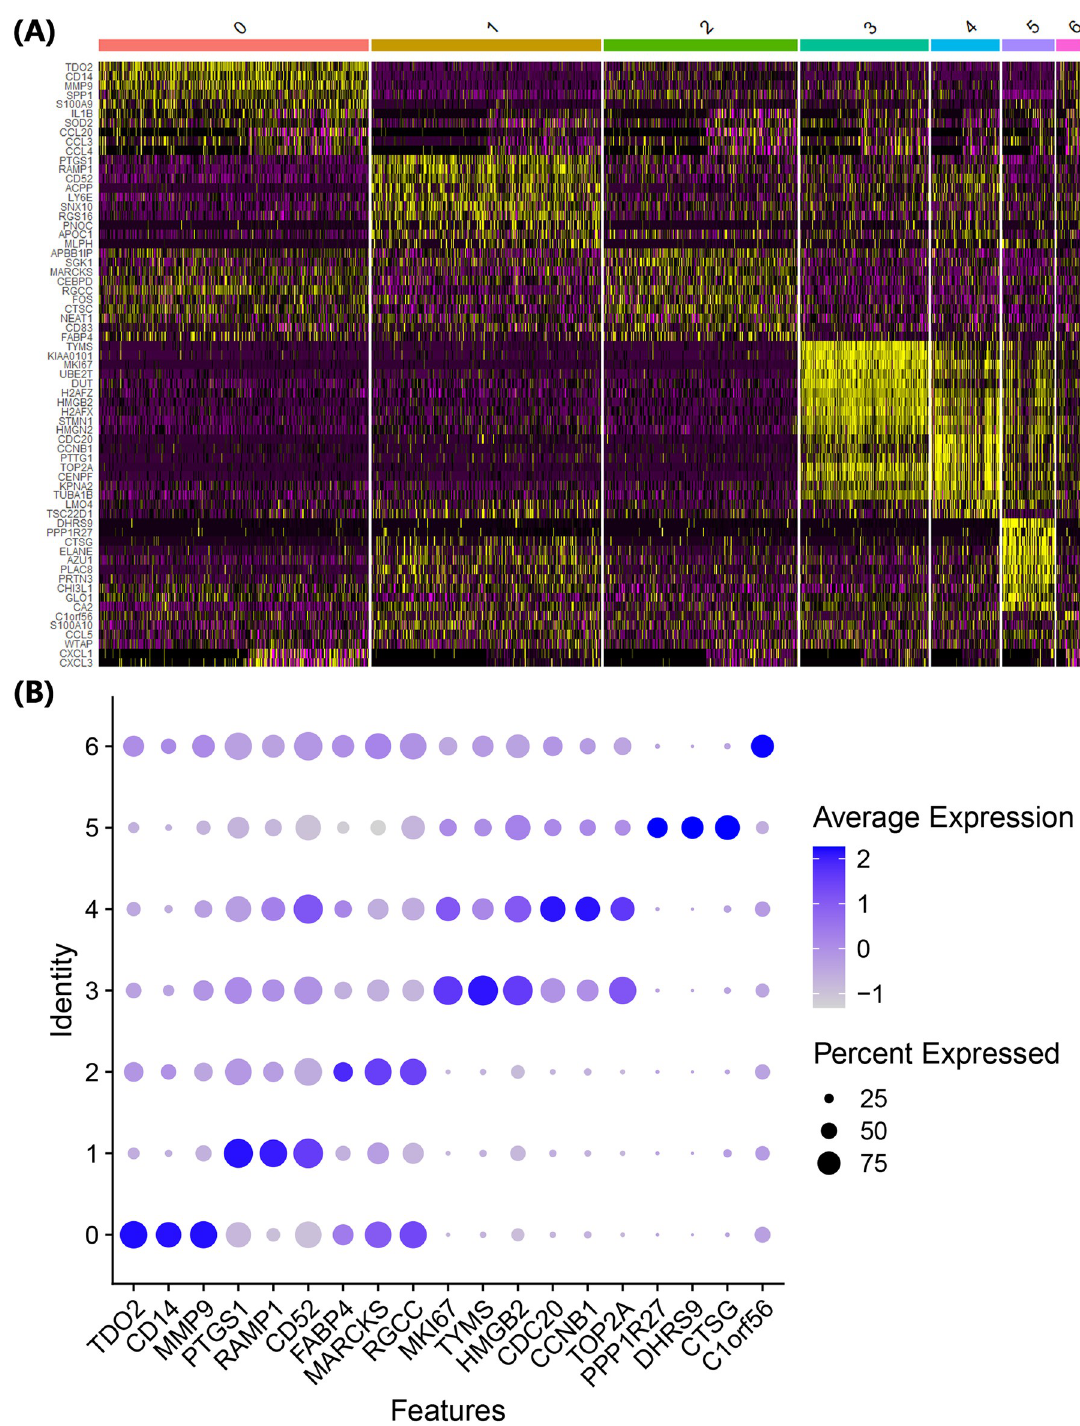
Fig 2. Expression of cluster-specific marker genes. Genes showing markedly different expression in each cluster are indicated by a heatmap (A), and the expression of cluster-specific marker candidate genes was compared using a dot plot (B).